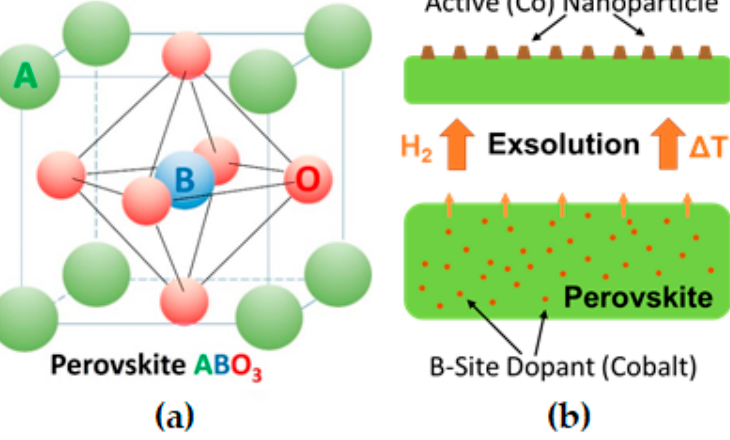
Figure 1. ( a ) Perovskite lattice structure; ( b ) simplified exsolution process.